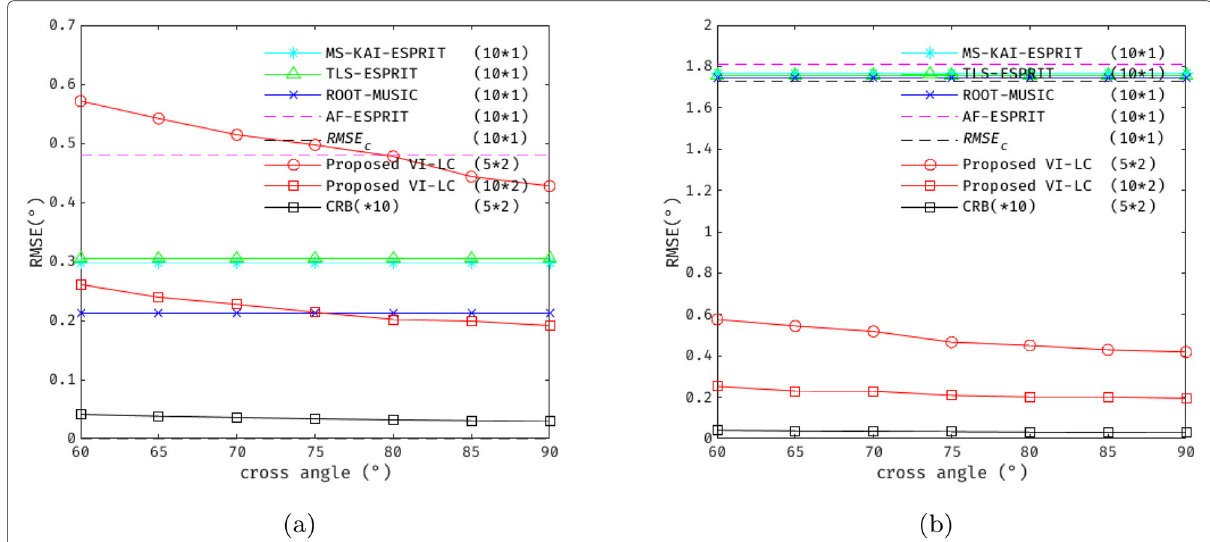
Fig. 4 RMSE versus cross angles. a (cid:8) c = 0 m/s and b (cid:8) c = − 25